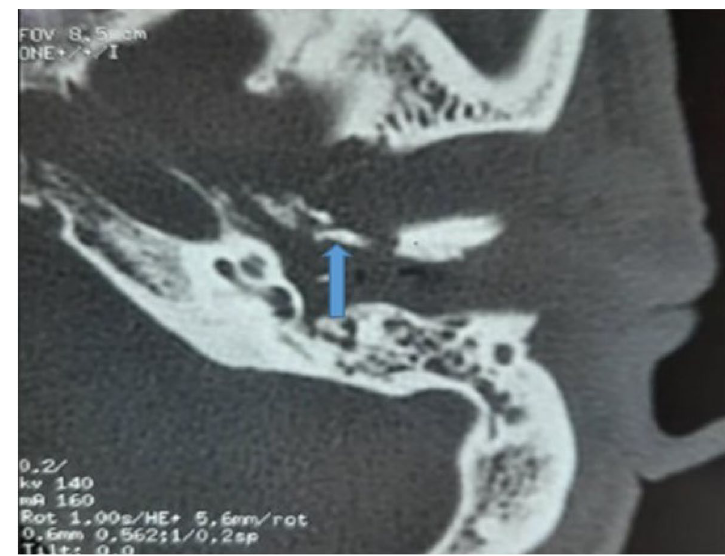
Fig. 1 CT scan of the temporal bone in axial section showing osteolysis of the tympanal bone with bone sequesters